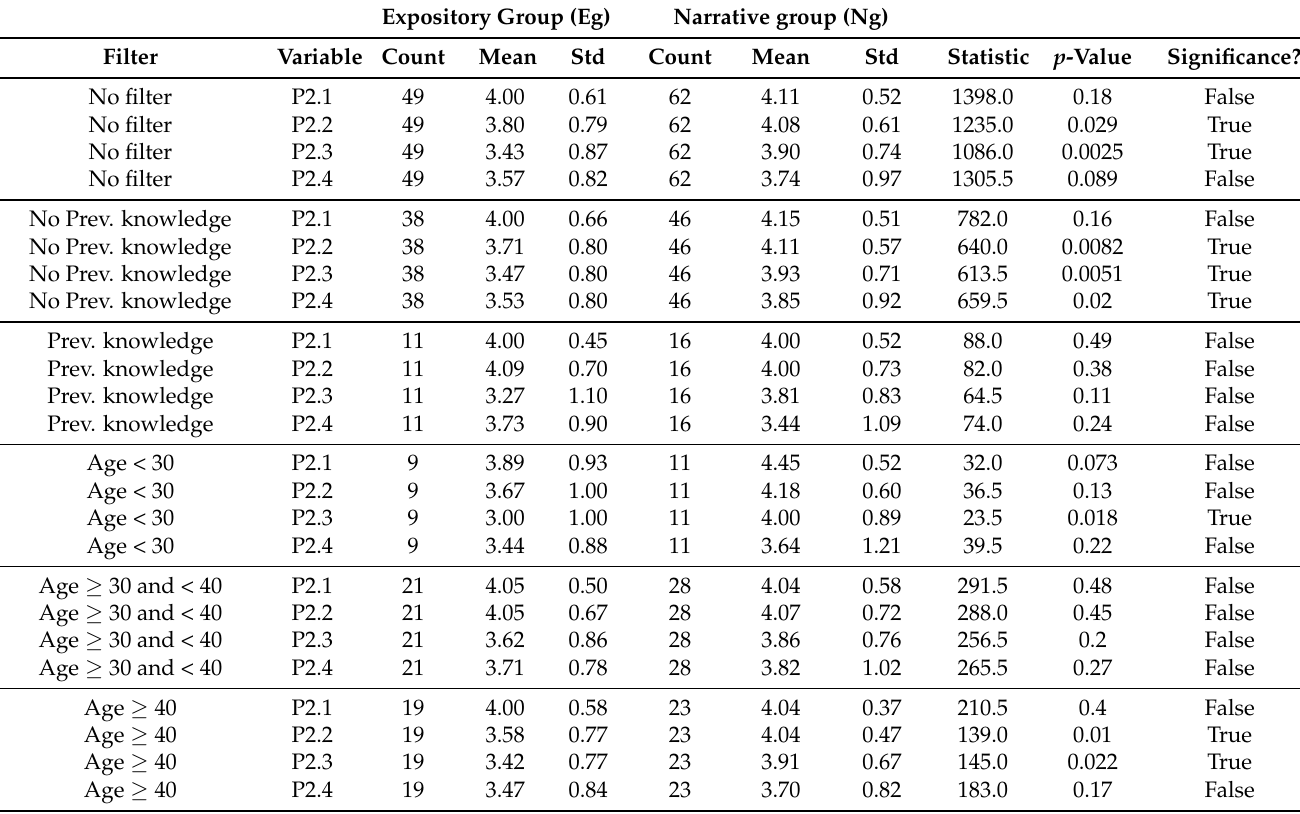
Table 3. Results of the Mann–Whitney U test of the variables related to the self-evaluation questions. Expository Group (Eg)